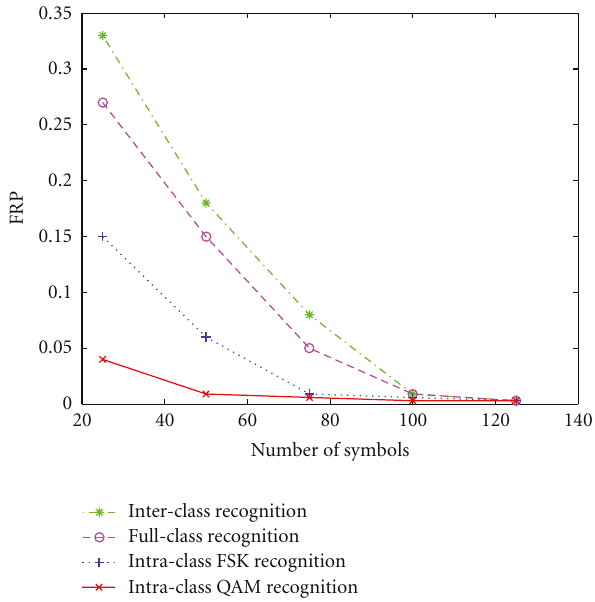
Figure 10: False recognition probability versus number of symbols (inter-class recognition, full-class recognition, intra-class QAM recognition, and Intra-class FSK recognition).